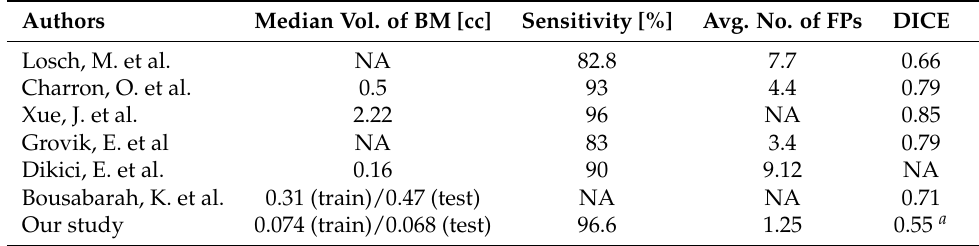
Table 4. Comparison between our study and other